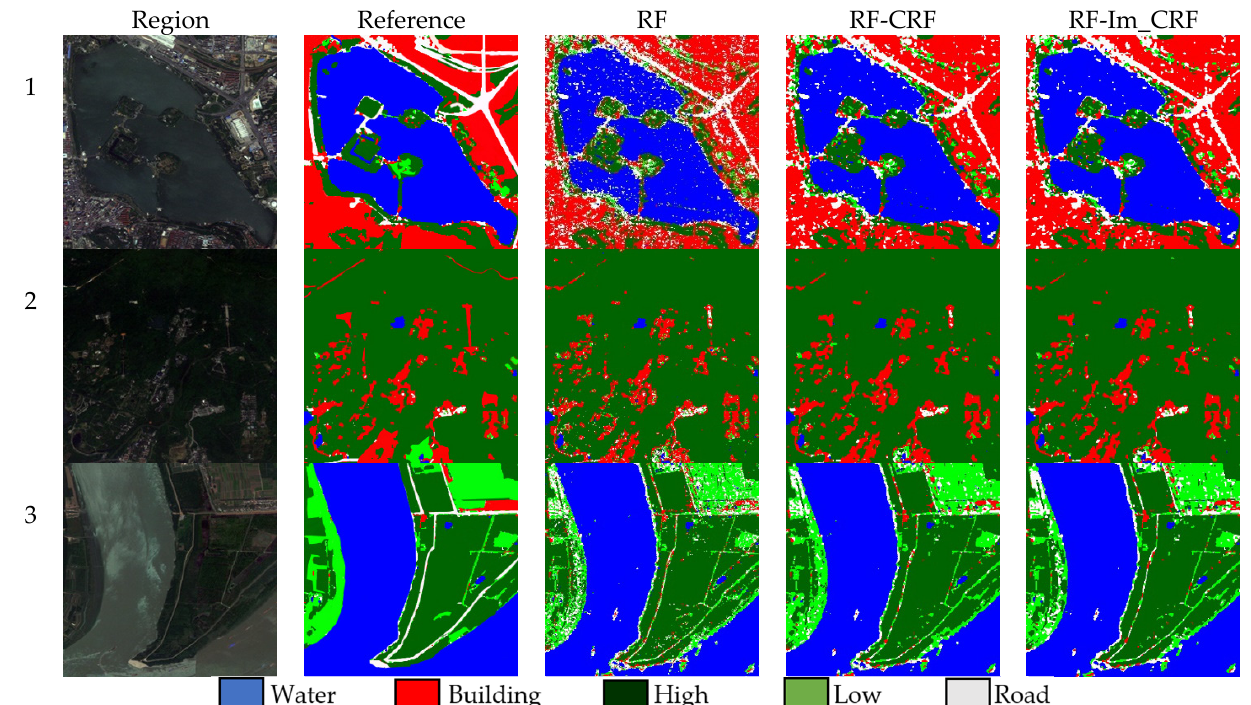
Figure 5. Sub-area classification results. The regions numbered 1, 2, and 3 are the corresponding subregions in Figure 1a.